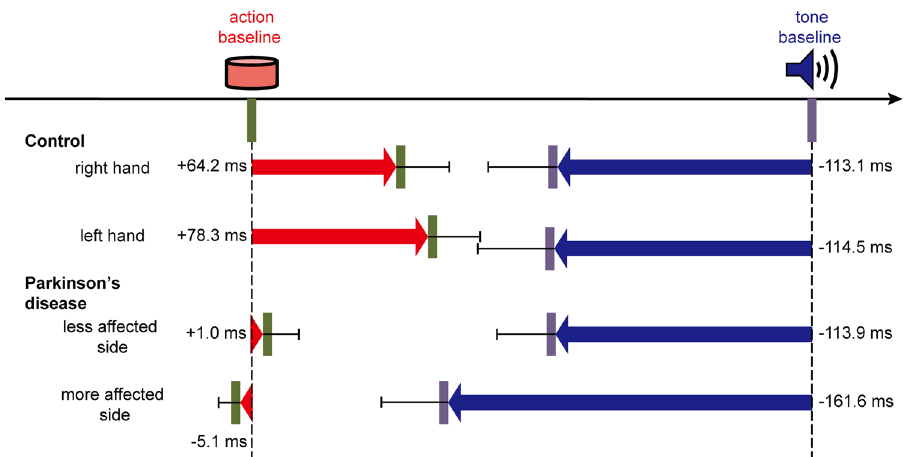
Figure 1. Perceived times of actions and tones in controls and in PD group. Red arrows represent perceived timing of actions, and blue arrows represent perceived timing of tones in agency condition compared to baseline condition. Bars represent standard